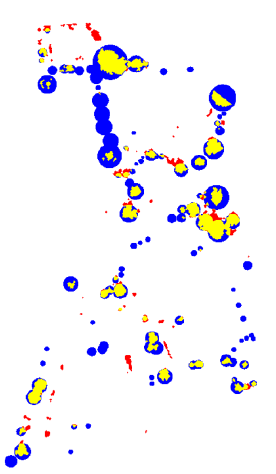
Figure 5. Trees classification (correctly classified as yellow, misclassified as red, missing as